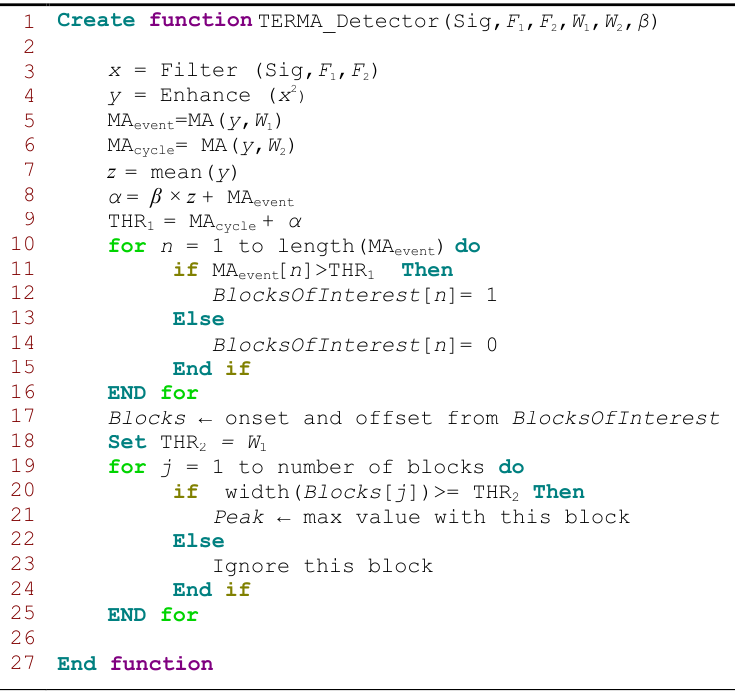
Figure 3. Pseudocode for the TERMA-based detector function. The function has six inputs: biomedical signal (Sig), F 1 , F 2 , W 1 , W 2 and β . The band-pass filter will be determined by the frequency band F 1 – F 2 Hz, while W 1 and W 2 are the window sizes of the two moving averages MA event and MA cycle , respectively. However, β is used to calculate the statistical threshold α